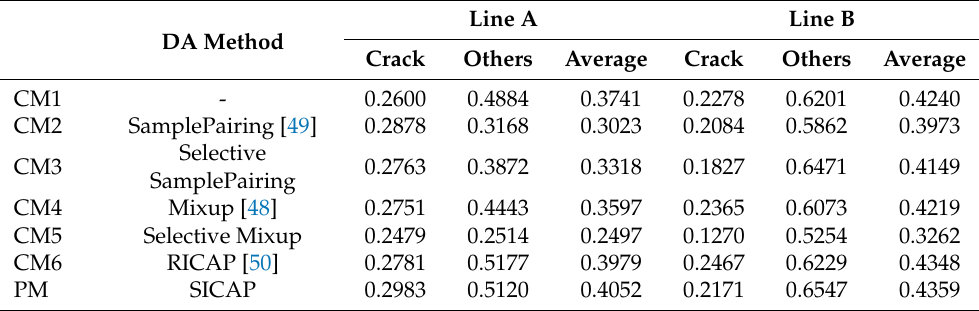
Table 2. Average of IoU when detecting “crack” and “others” based on each data augmentation method (DA method) in experiment